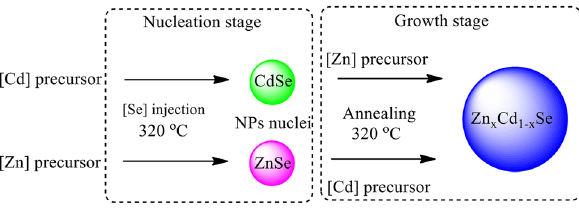
Figure 2: Schematic representation of the synthesis approach proposed in